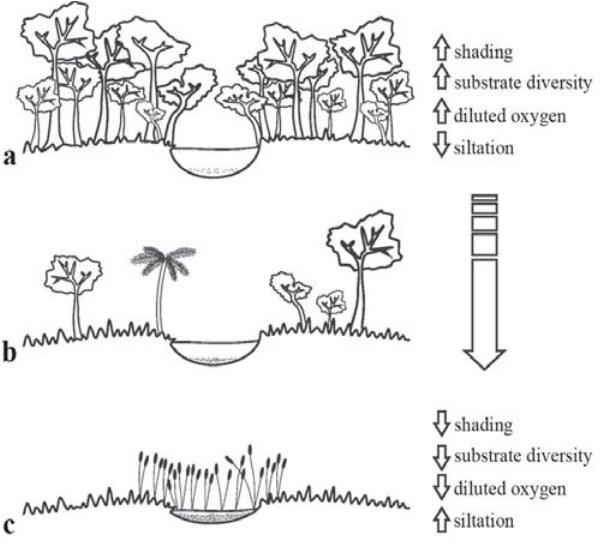
Fig. 1. Characteristic stages of the degradation process of riparian zones in a stream. a ) streams with preserved riparian forests (PRE); b ) with riparian forests in intermediate stage of degradation (INT); c ) without riparian forests and in advanced stage of degradation